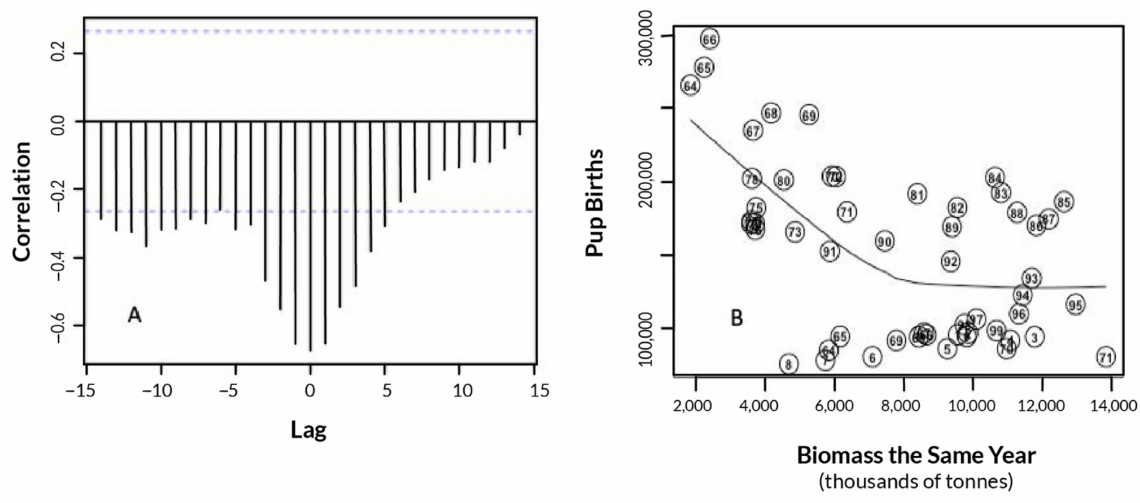
Figure 5. ( A ) Cross correlation between estimated eastern Bering Sea biomass at different lags and female northern fur seal pup births on St. Paul Island from 1964 through 2018. The peak in correlation is negative at a lag of zero, with a much smaller peak at a lag of − 11, where biomass is slightly negatively correlated with female pup births in the future. ( B ) St. Paul fur seal pup births as a function of pollock biomass in the same year. The line in B is a LOWESS smoothing curve. The two-digit numbers used for plotting represent the years of the pollock catch in the 1990s. The one-digit codes indicate the years in the